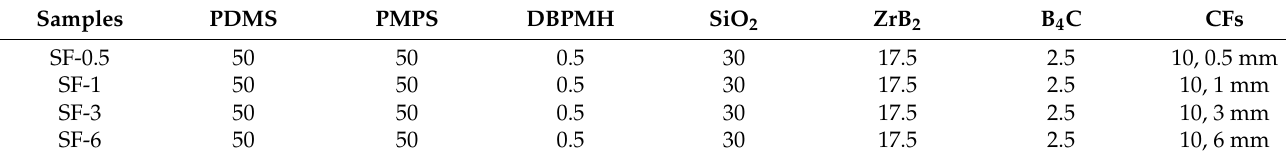
Figure 1. Schematic illustration of the fabrication of ablative samples. Table 1. Composition of the samples (part per hundred grams silicone rubber).